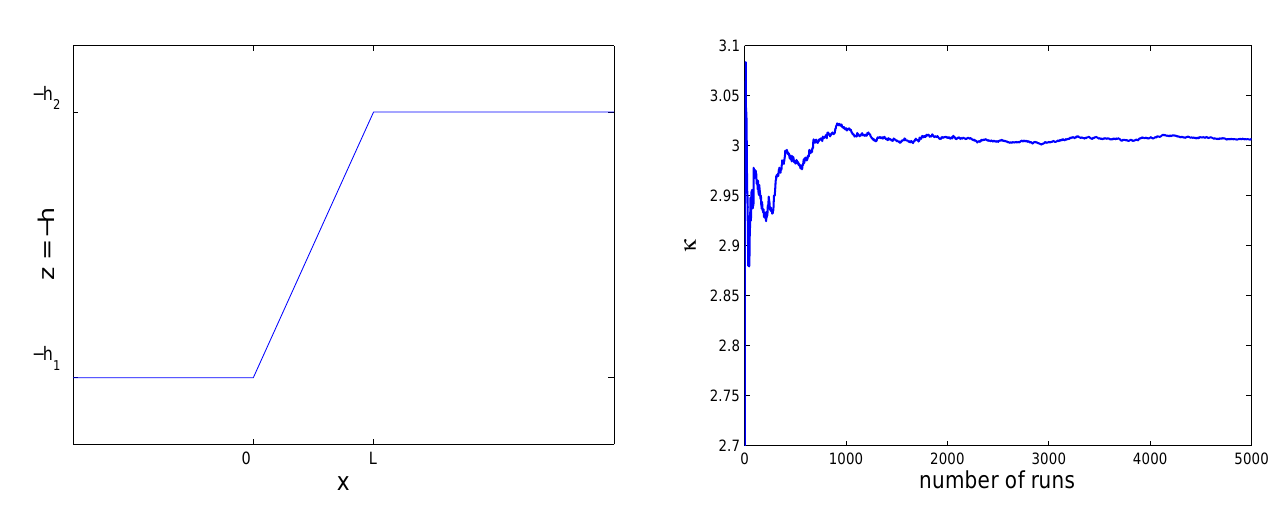
Fig. 2. Plot of depth. Fig. 3. Typical convergence of the ensemble-averaged kurtosis with respect to the number of runs in the